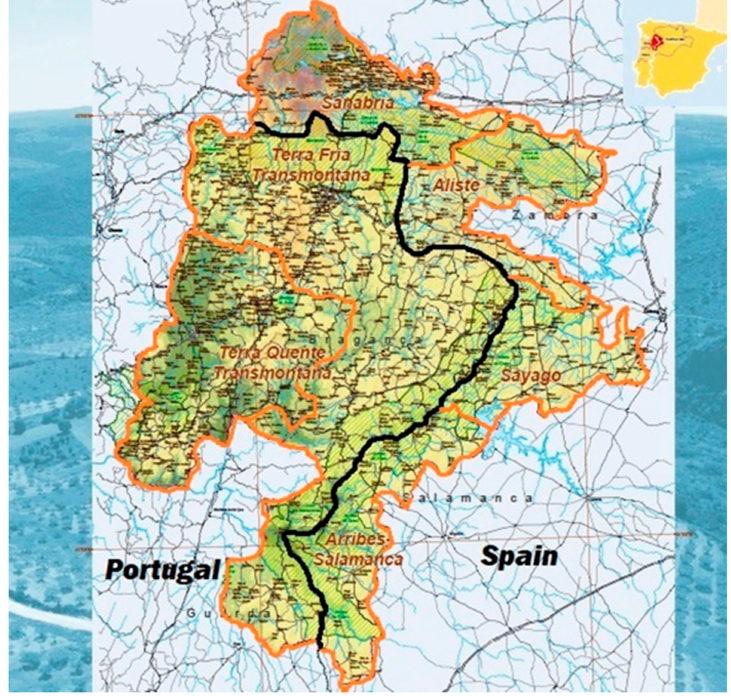
Figure 3. Historical landscape units of the